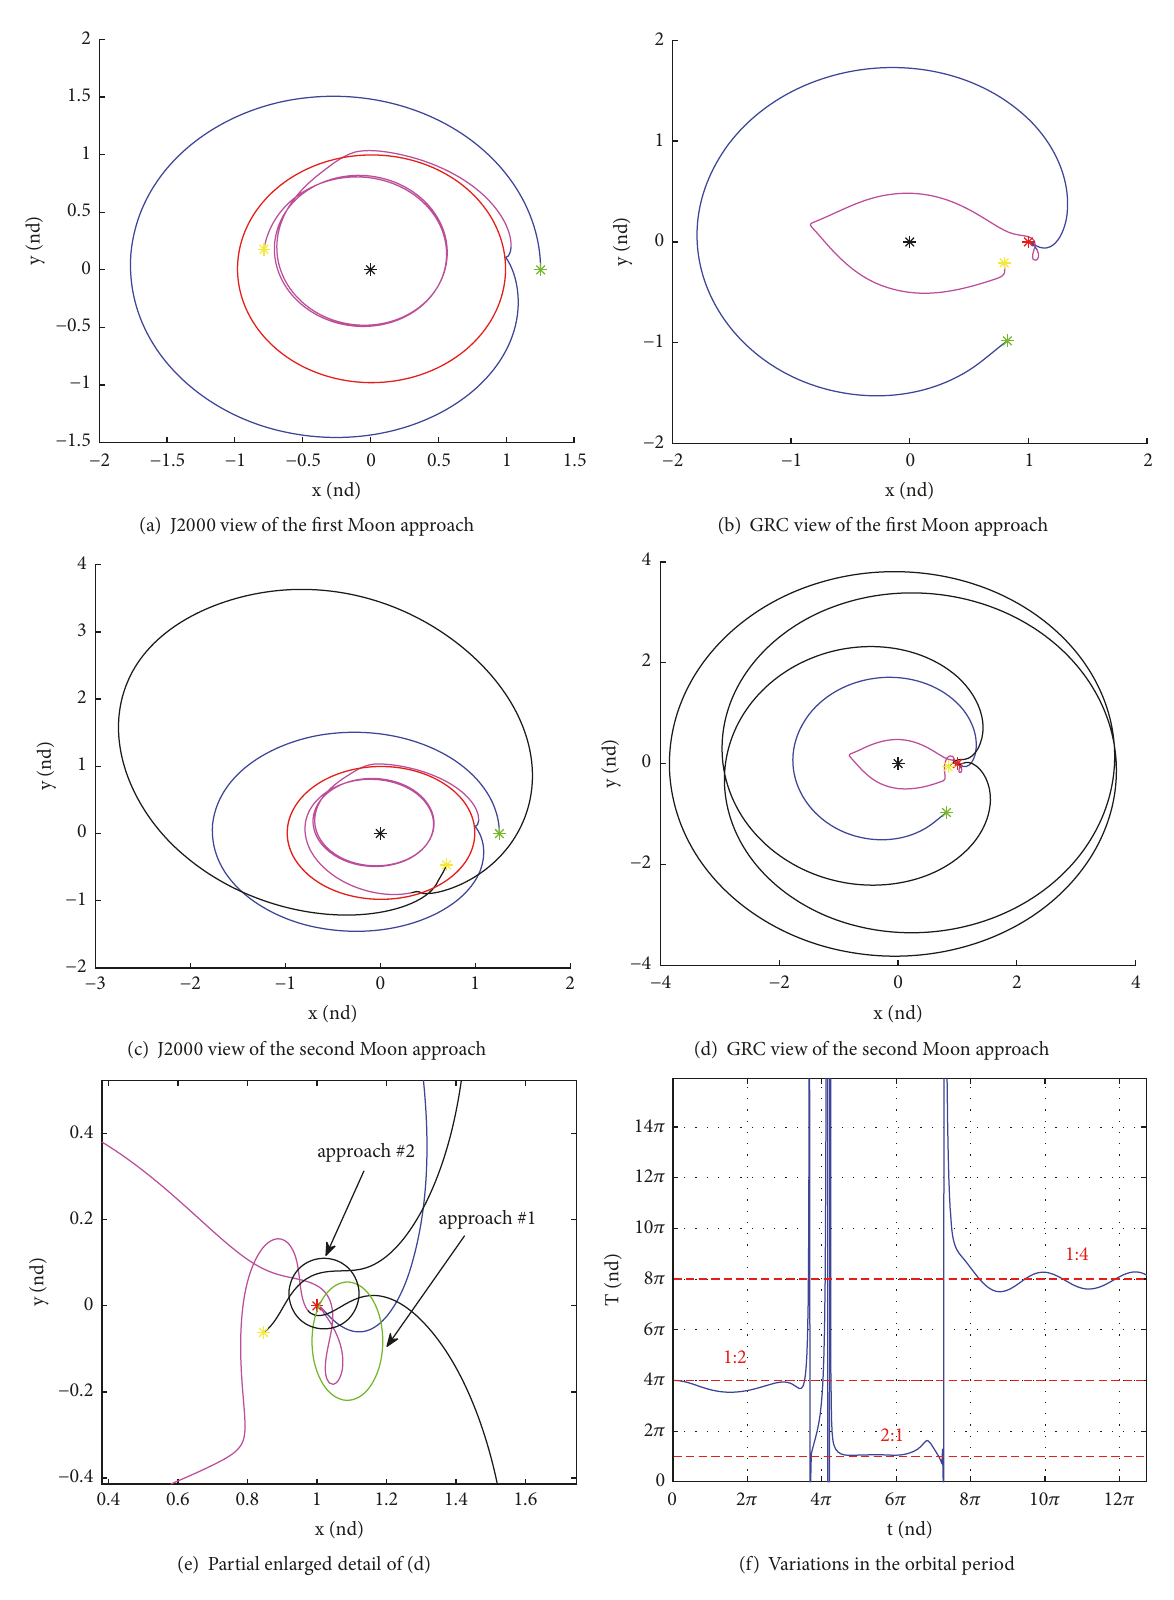
Figure 12: Resonance transition and weak capture by the Moon in the 1:2 resonant orbit with e = 0.21, 𝜃 0 = 10 ∘